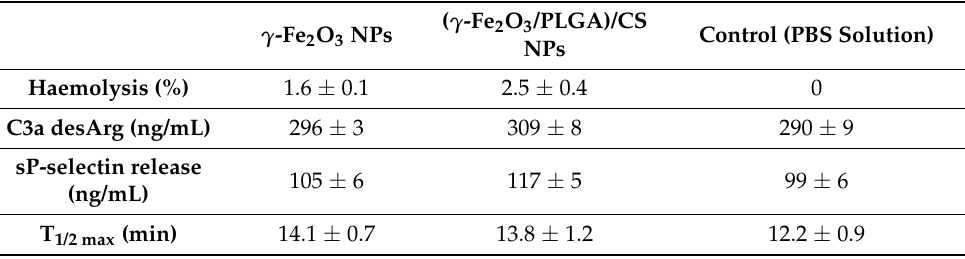
Figure 6. In-vitro cytotoxicity (RCV, %) of the ( γ -Fe 2 O 3 /PLGA)/CS NPs in CCD-18 cells at 48 h (blue columns) and 72 h (green columns), and in T-84 cells at 48 h (dark blue columns) and 72 h (dark green columns). These cell lines were kept in contact with NP concentrations, ranging from 0.05 to 100 μ g/mL. Table 2. Effect of the γ -Fe 2 O 3 , and ( γ -Fe 2 O 3 /PLGA)/CS NPs on haemolysis (%), complement acti- vation (C3a release: C3a desArg, ng/mL), platelet activation (sP-selectin release, ng/mL), and plasma recalcification time (T 1/2 max , min). Data is indicated as means ± SDs ( n = 3).